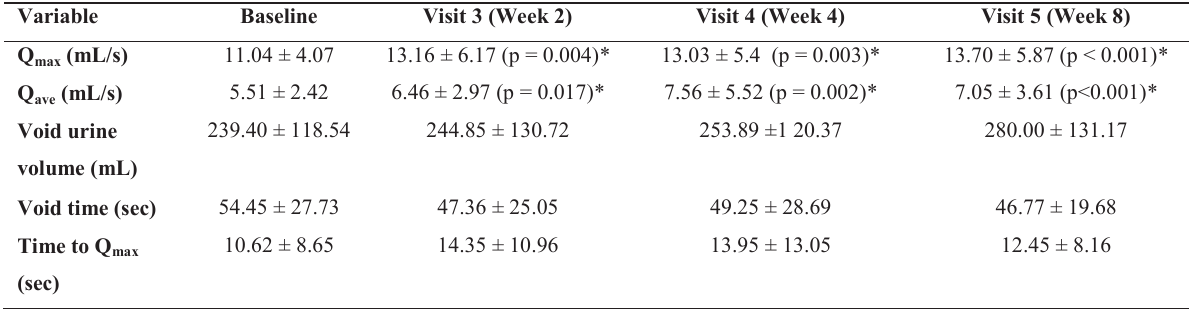
Table 3 - Uroflowmetry outcomes at baseline and after 2, 4 and 8 weeks of treatment.